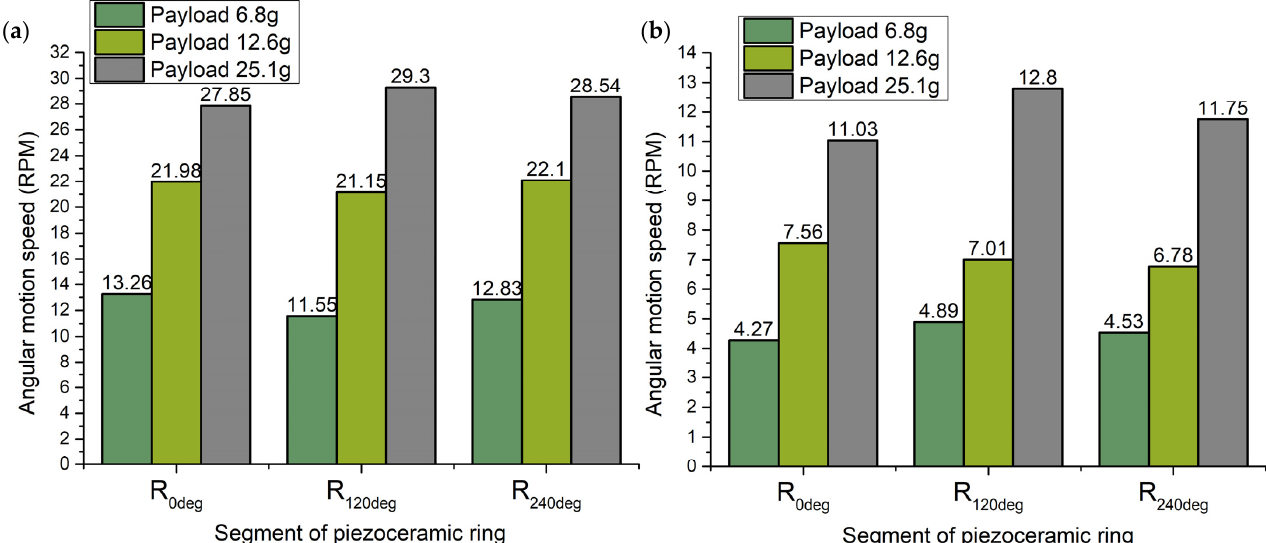
Figure 19. Comparison of the highest and lowest angular motion values; ( a )—the highest angular motion speeds when the voltage of 200 V p-p is applied; ( b )—the lowest angular motion speed values when the voltage of 80 V p-p is applied.